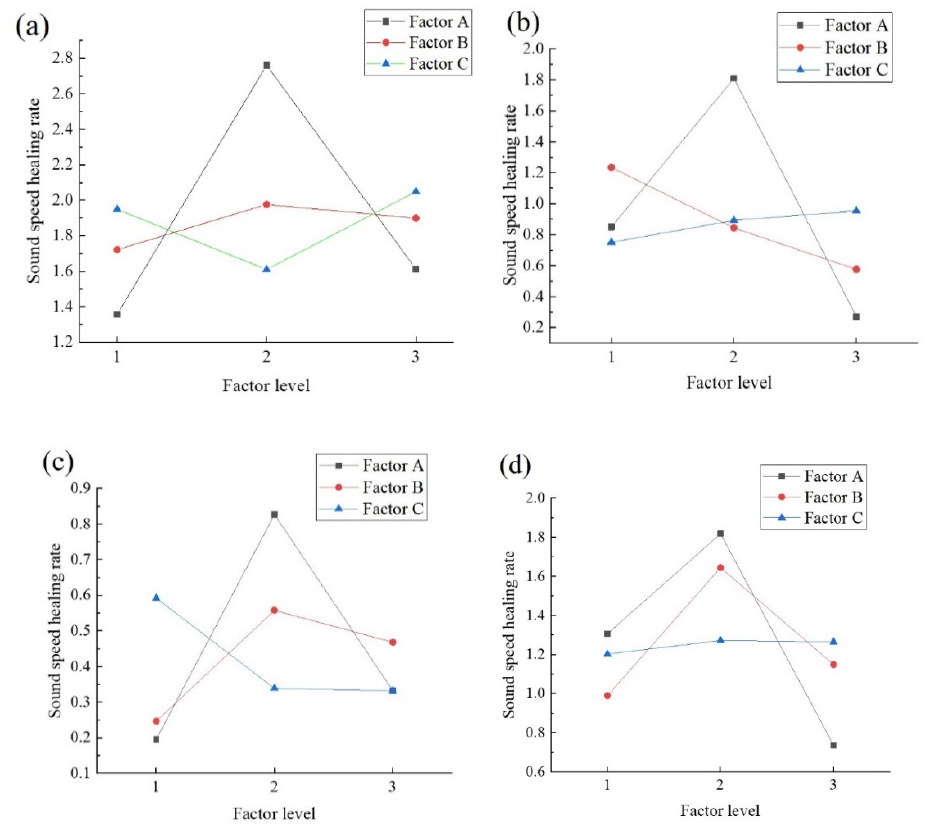
Figure 4. K -value of the sound speed recovery rate for various factors. ( a ) 100% damage and aging for 7 d. ( b ) 90% damage and aging for 7 d. ( c ) 100% damage and aging for 28 d. ( d ) 90% damage and aging for 28 d.